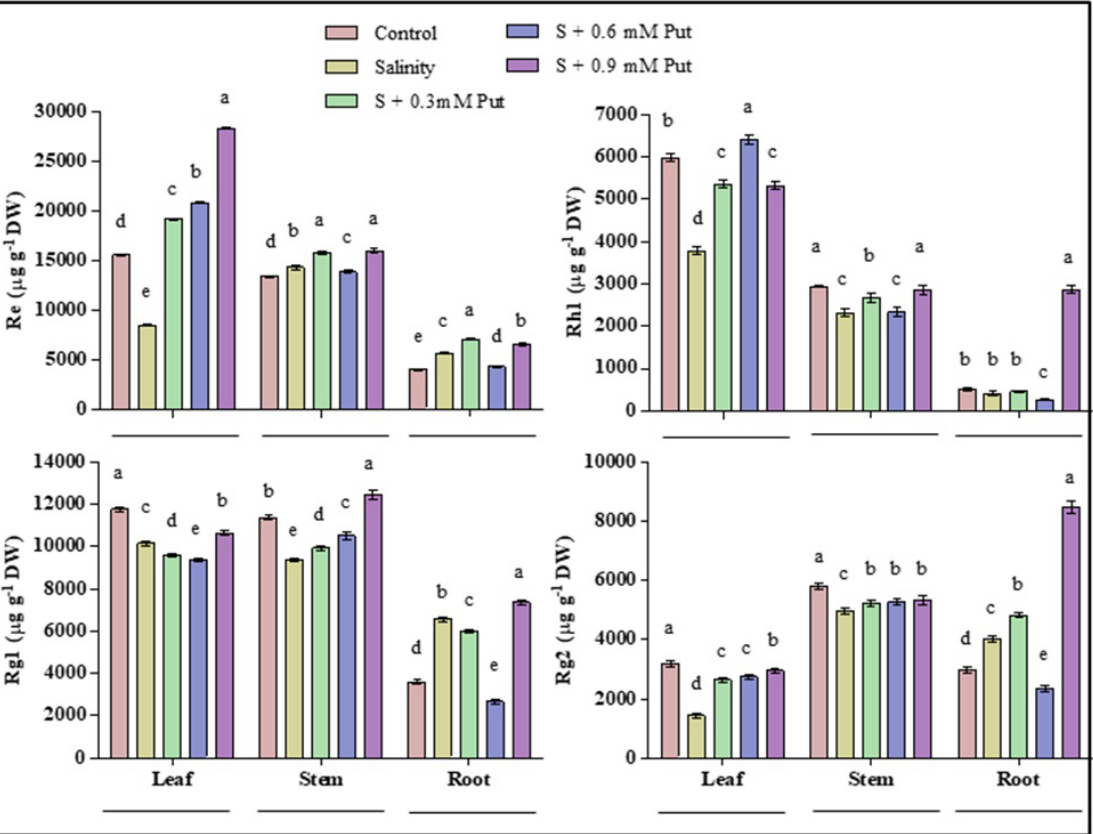
Figure 6. Effect of putrescine on ginsenosides (PPT type) in leaf, stem, and root of ginseng seedlings under salinity stress condition. Different letters indicate significant differences ( P ≤ 0.05) among the treatments within each parameter. Each value represents the mean ± SD ( n = 3).